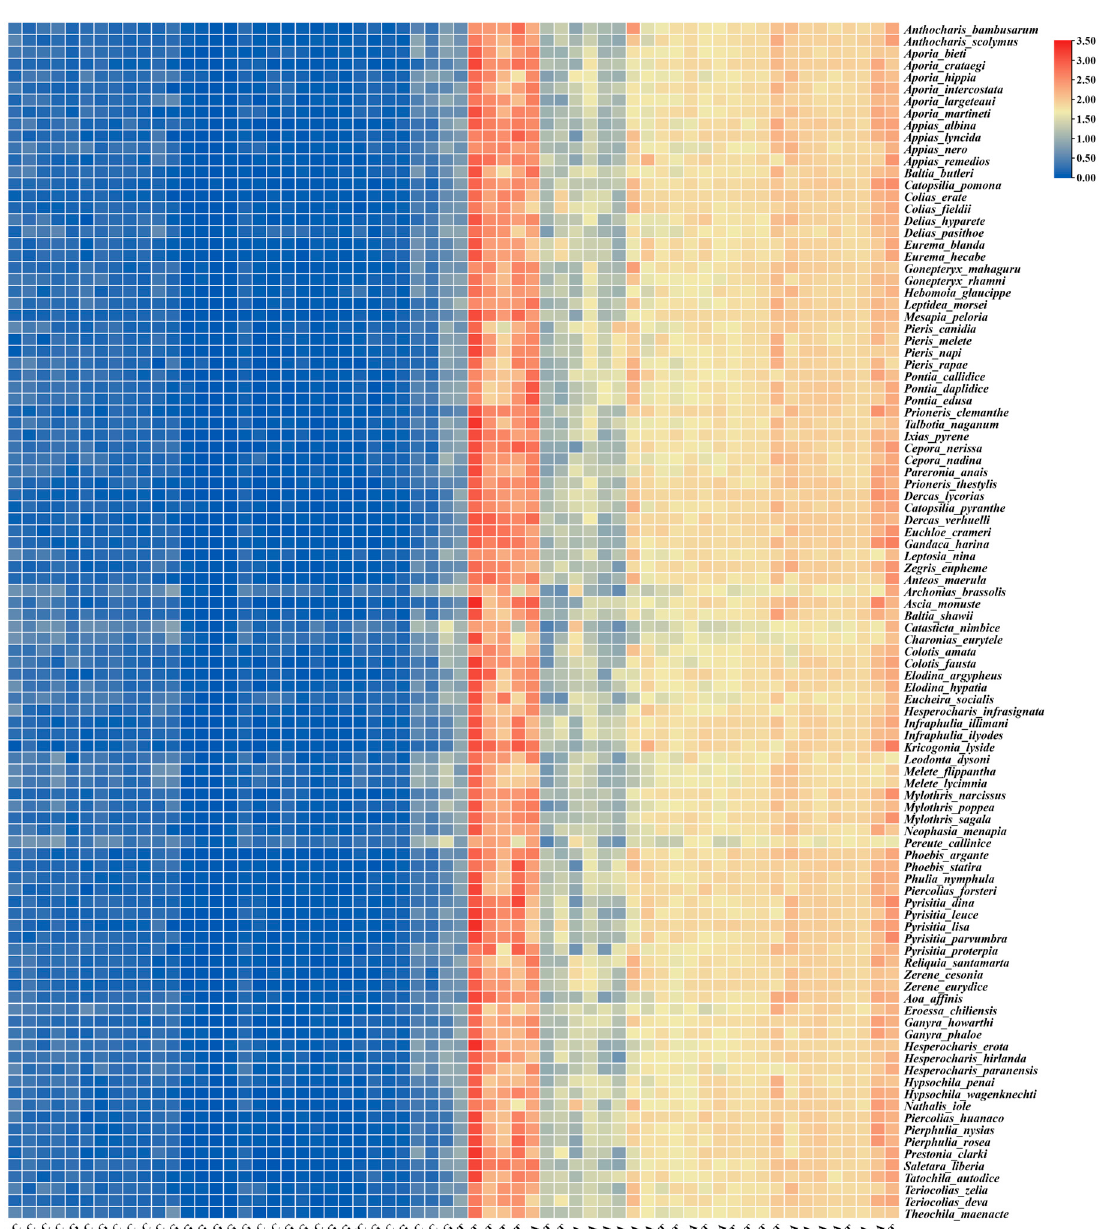
Figure 2. The relative synonymous codon usage (RSCU) of 13 PCGs in the mitogenomes of Pieridae. The x- and y-axis represent the codon type and species name, respectively. The legend in the upper- right corner represents the usage frequency of synonymous codons.